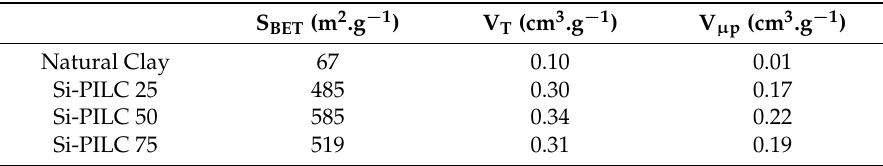
Table 2. Textural properties for the materials. (PILC: pillared